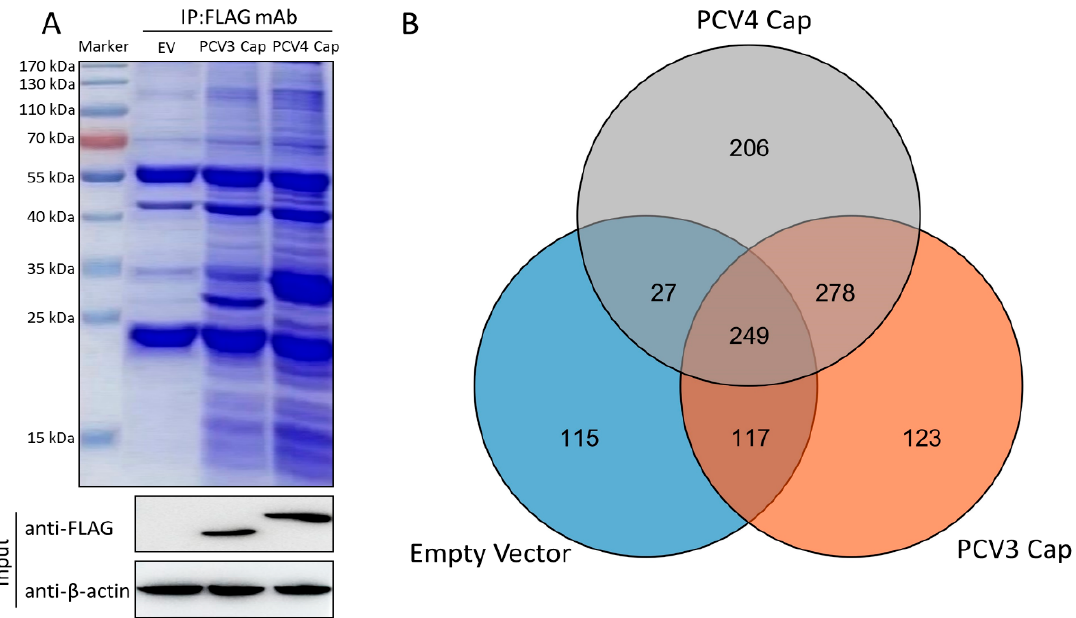
Figure 1. Characterization of PCV3 or PCV4 Cap-interacting cellular proteins. ( A ) Empty vector, PCV3, or PCV4 Cap-transfected PK-15 cells were harvested at 48 hpt, and a co-immunoprecipitation assay was performed using anti-FLAG beads. PCV3 or PCV4 Cap-interacting host proteins were eluted and analyzed via SDS-PAGE followed by Coomassie blue staining. Lane 1, protein molecular weight ladder; lane 2, empty vector-transfected; lane 3, PCV3 Cap-transfected; lane 4, PCV4 Cap- transfected. ( B ) Venn diagram of the identified protein candidates interacting with PCV3 or PCV4 Cap from the empty vector-transfected, PCV3 Cap-transfected, and PCV4 Cap-transfected cells, respectively. Blue, orange, and gray colors indicate proteins from the empty vector-transfected, PCV3 Cap-transfected, and PCV4 Cap-transfected cells, respectively. Common proteins within the data sets are indicated in the colored intersections. Proteins were represented as their respective NCBI gene names (Supplementary Table